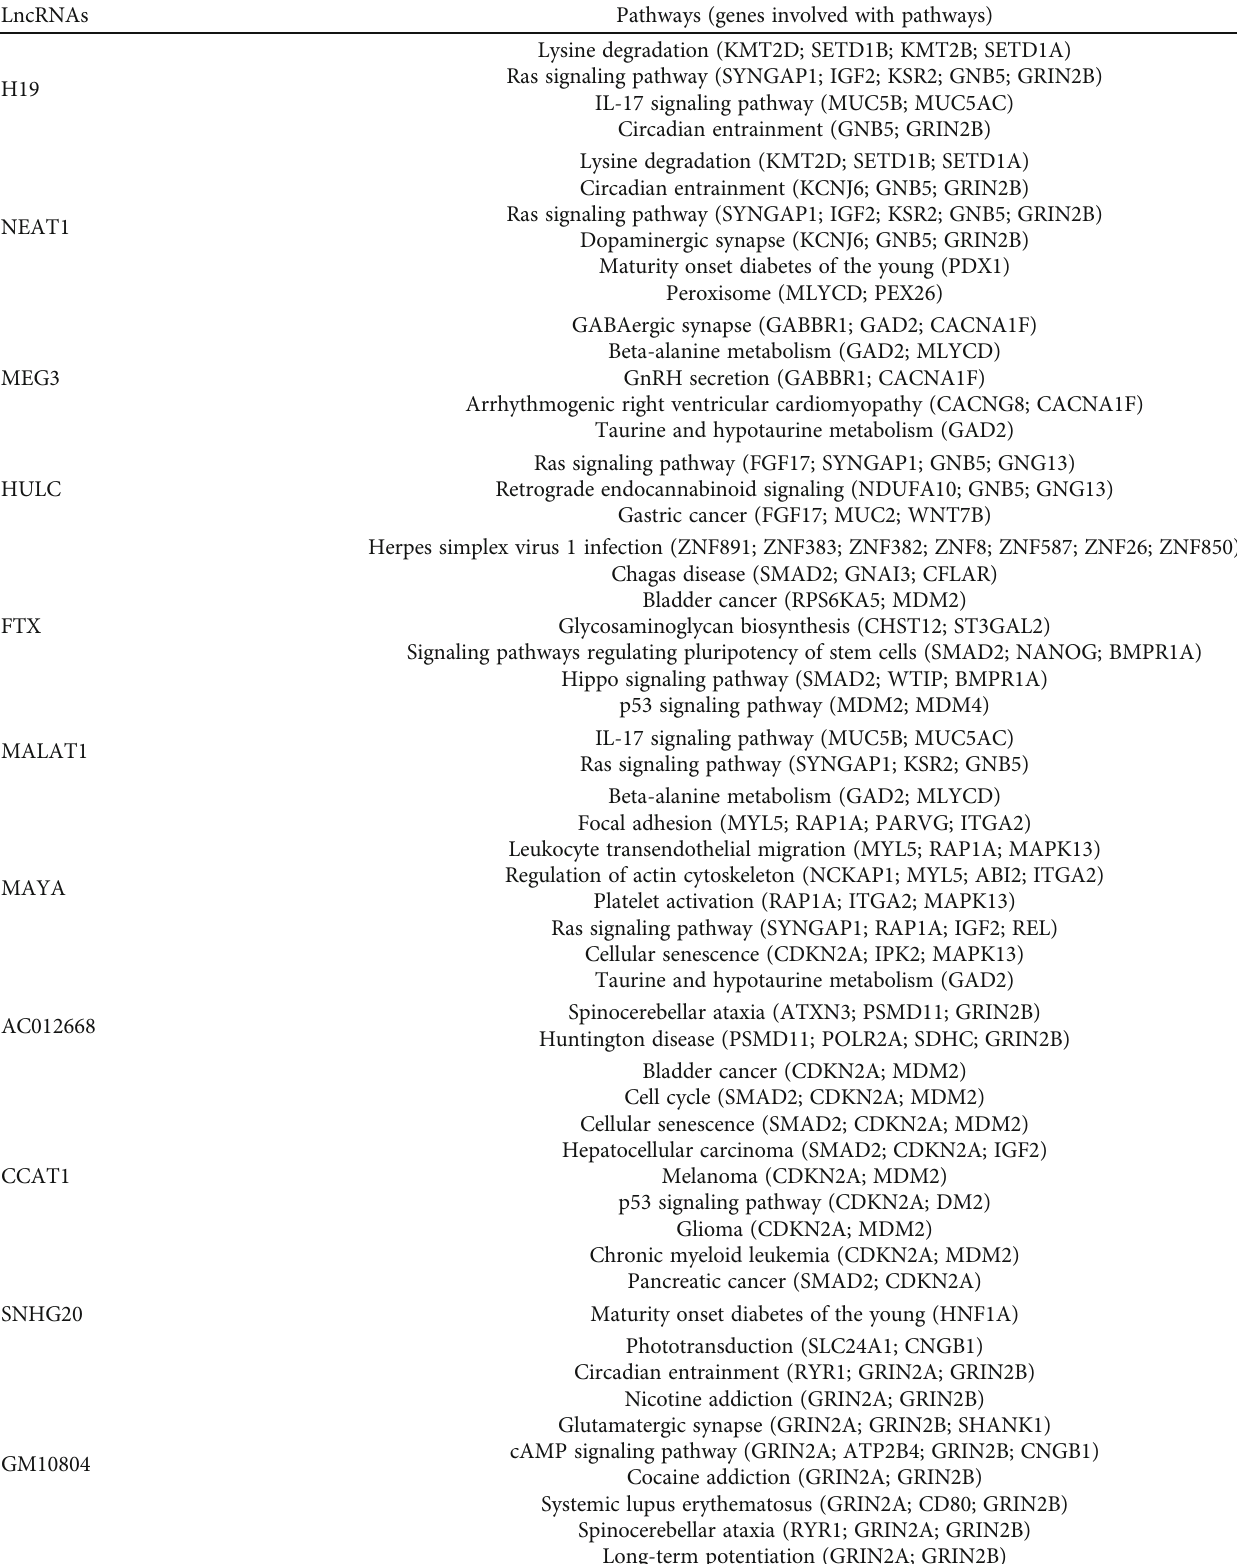
Table 2: Pathways and genes associated with